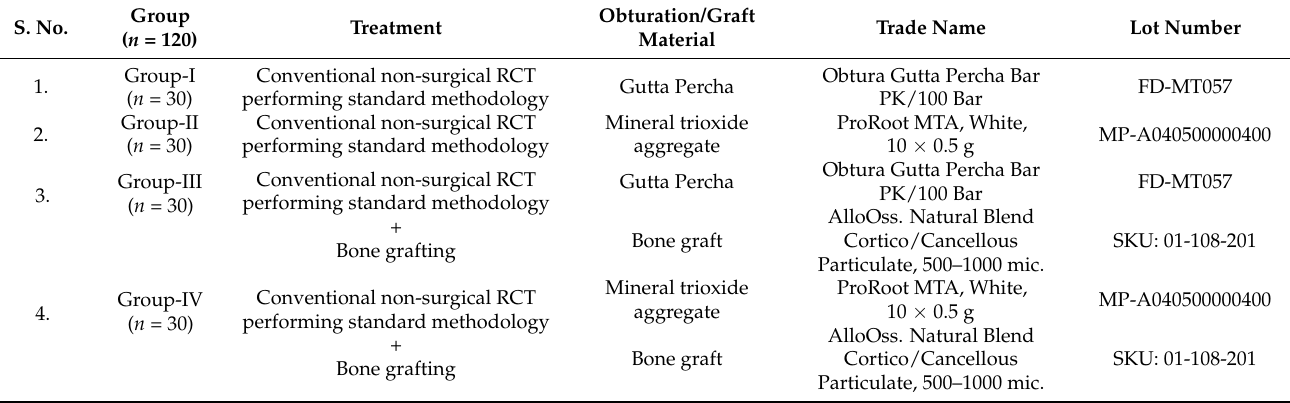
Table 1. Details of the tested groups and materials used in the research